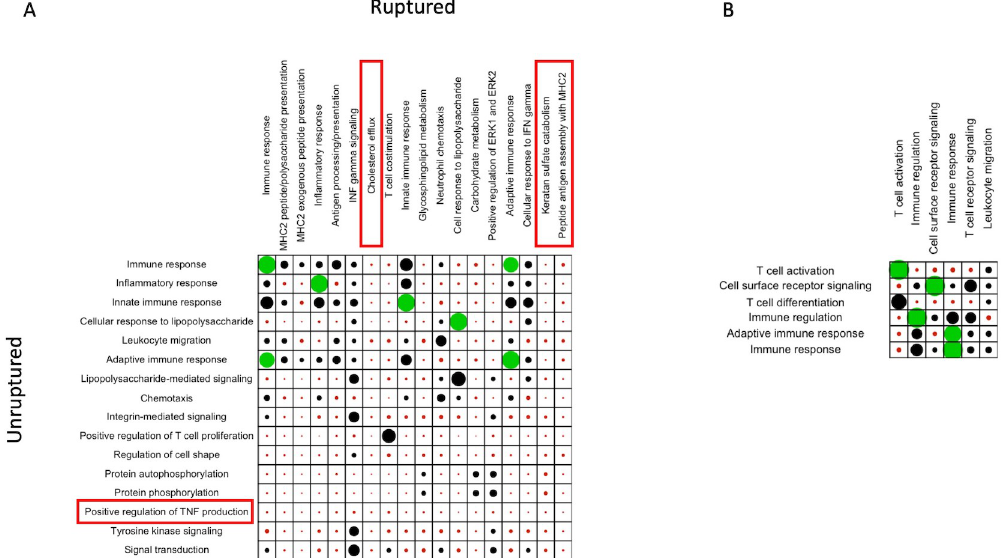
Fig 3. GoSemSim reveals differences in biological mechanisms between ruptured and unruptured aneurysms. A and B: Balloon plots of significant GO term similarity measure (S) for macrophage (A) and T cell (B) populations, with terms of ruptured and unruptured aneurysms represented as columns and rows, respectively. Dot size is proportional to S, and green dots represent high similarity (S > 0.8) while red dots represent low similarity (S < 0.2). Red boxes highlight processes which have low association with the GO terms of the opposite phenotype (i.e. C i for which S(A i ,x) < 0.2 for any x in D, where C and D represent